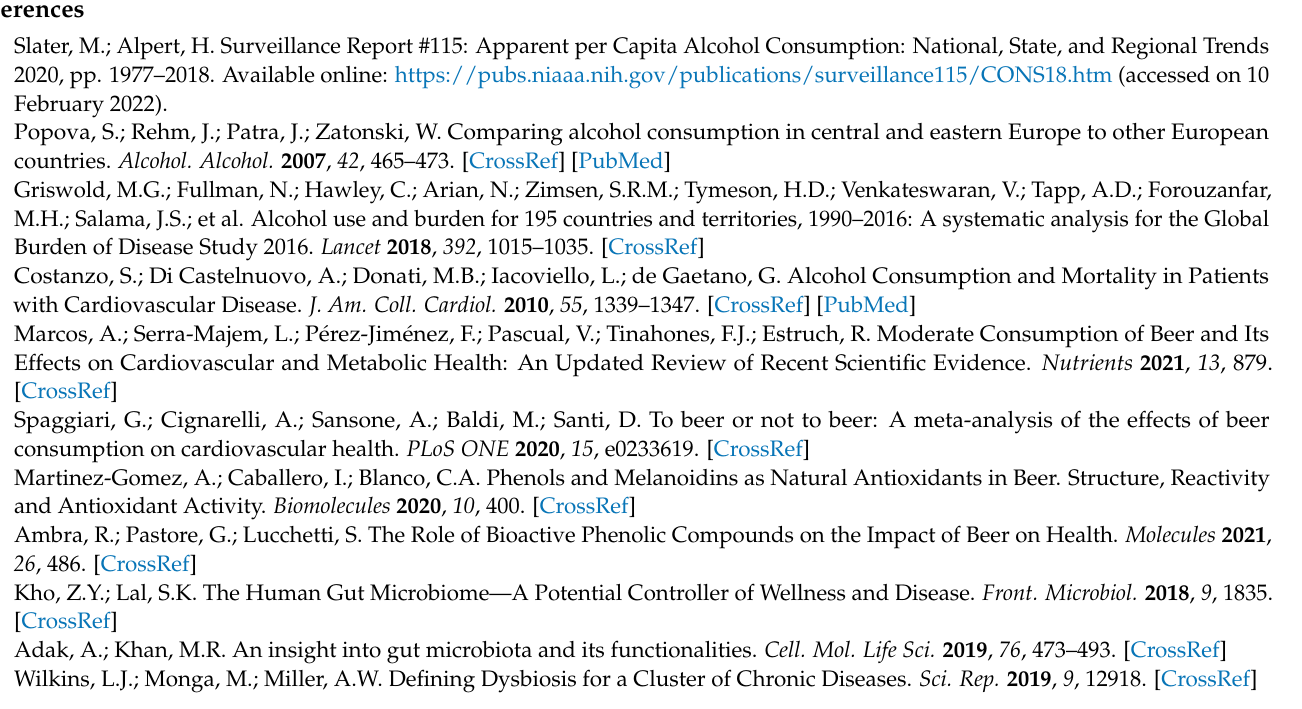
Table S1: Dietary assessment according to total energy and macronutrients/fiber intake of healthy volunteers and participants with metabolic syndrome; Table S2: Metacyc pathways evaluated after each intervention period. Table S3: Common and different Metacyc pathways in the evaluated intervention